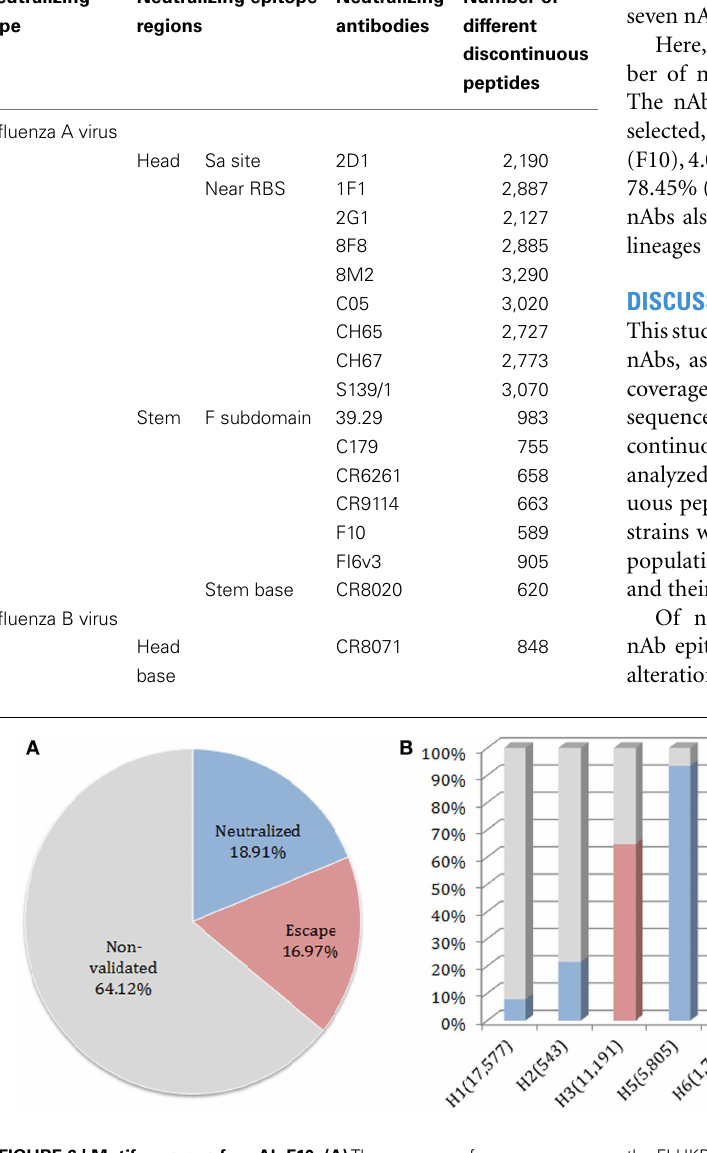
epitopes of each nAb in the HA sequence dataset .